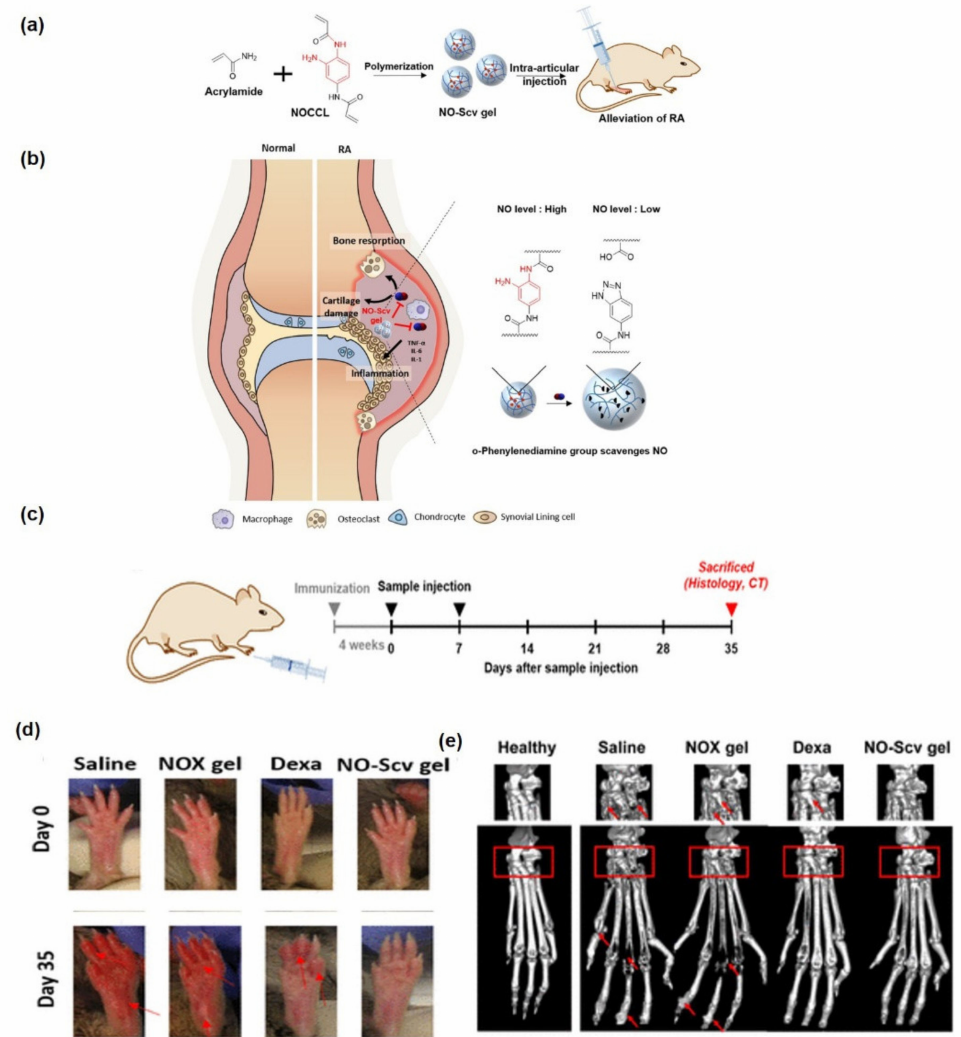
Figure 5. ( a ) Preparation of nitrous oxide (NO)-scavenging nanogel (NO-Scv) to alleviate rheumatoid arthritis. ( b ) NO-Scv nanogel prevents NO-mediated cartilage damage, inflammation, and bone deformation. ( c ) In vivo efficacy studies with NO-Scv nanogel in collagen-induced arthritis mouse model suggest ( d ) reduction in paw volume and swelling. ( e ) Monitoring of bone and joint morphol- ogy by computer tomography revealed clear boundary of bone and less bone erosion in both the ankles and fingers of mice as compared to those in the saline and NOx gel-treated animal group. Adapted with permission from ref. [91], Copyright 2019 American Chemical